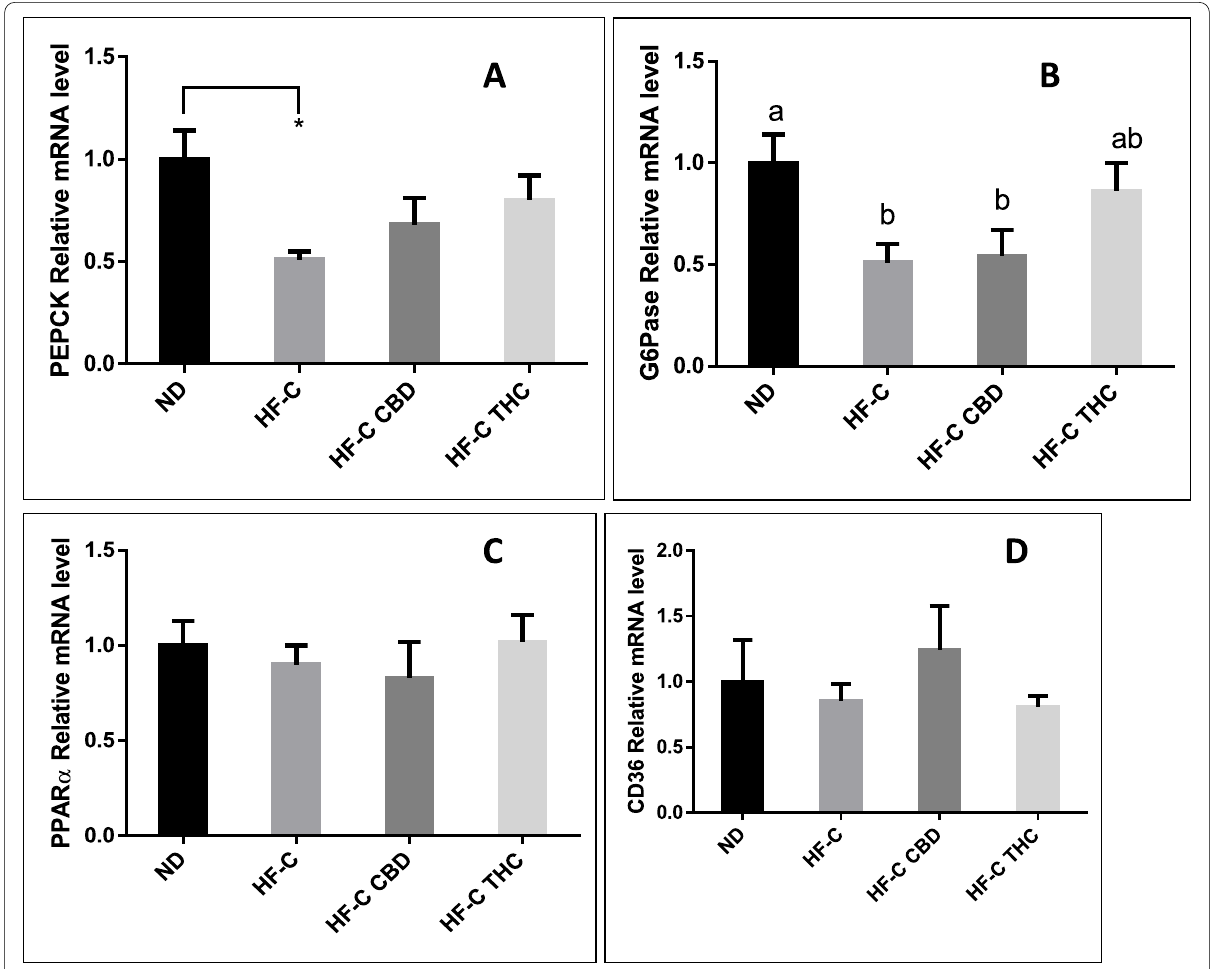
Fig. 5 Effect of THC or CBD treatment on RNA expression of carbohydrate and lipid metabolism‑related genes in mice fed HFCD. Male C57BL/6J mice aged 7–8 weeks were fed either normal diet (ND, n containing CBD (2.39 mg/kg) (HF‑C CBD, n was isolated from harvested livers and gene levels quantified using qPCR. Values are expressed as mean of relative expression compared to ND SEM. Values marked with different letters are significantly different ( p < 0.05) in the Tukey–Kramer